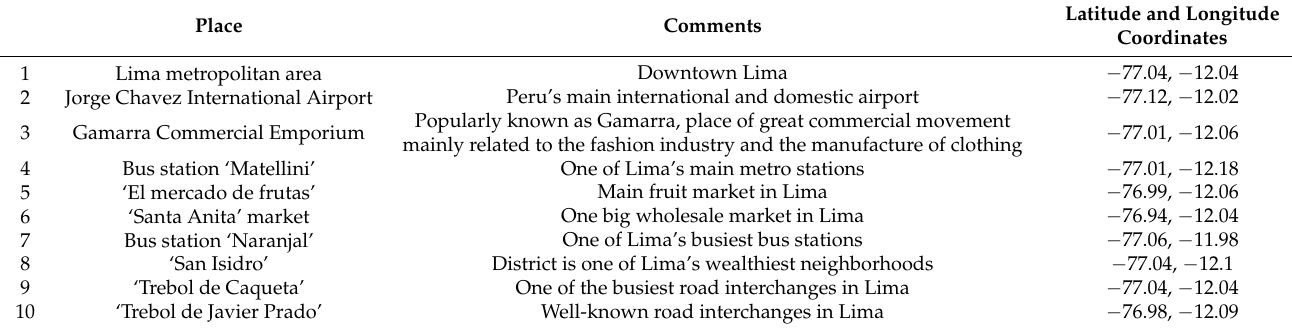
Table 1. Eighteen places in Lima selected to analyze pollution patrons in the capital of